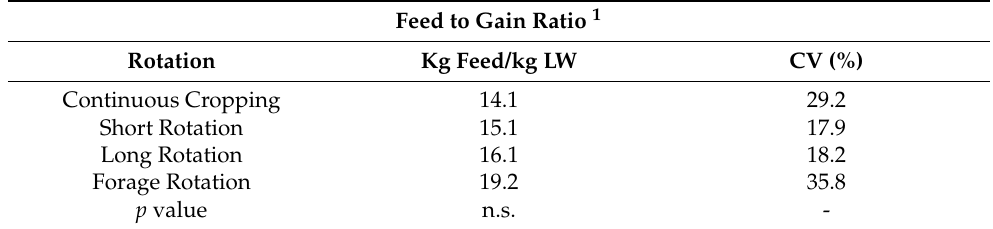
Table 10. Feed to Gain ratio (kg feed/kg LWP) and coefficient of variation (CV, %) in the ‘Palo a Pique’ pasture–crop rotations long-term experiment in Treinta y Tres, Uruguay.